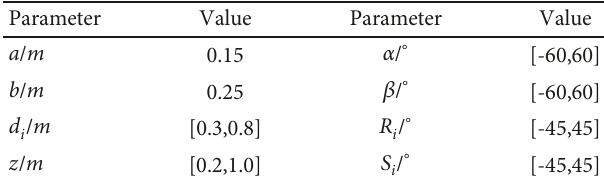
Table 4: Architecture parameters of the proposed